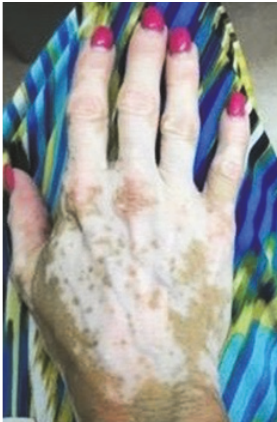
Figure 1: Clinical appearance of the right dorsal hand 5 and a half months after beginning apremilast.